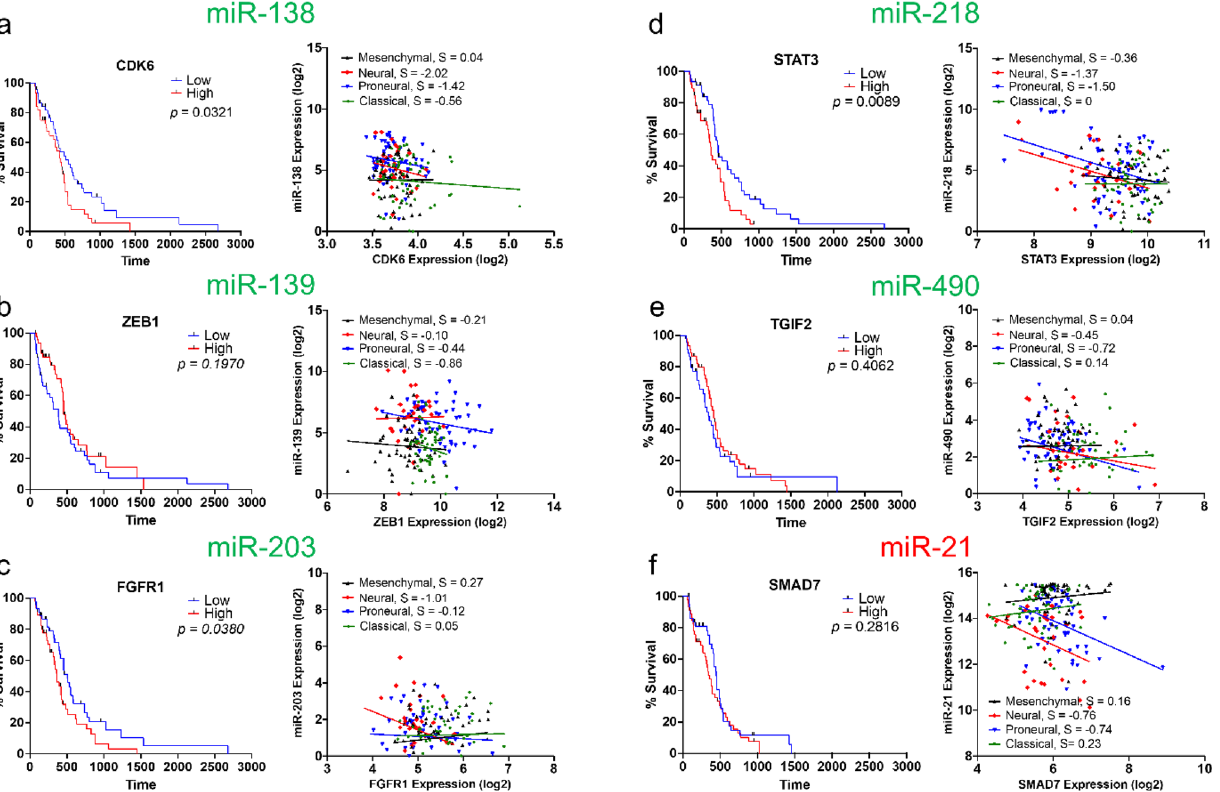
Figure 2. Survival curves of the target genes for each of the six selected miRNAs, and correlation of each target genes with respective miRNA expression. Correlation between the target gene and miRNA were studied in four different GBM subtypes: mesenchymal, neural, proneural, and classical. ( a ) miRNA-138/CDK6-involved in proliferation. ( b ) miRNA-139/ZEB1-involved in migration and invasiveness. ( c ) miRNA-203/FGFR1- involved in mesenchymal transition. ( d ) miRNA-218/STAT3-involved in cytokine signaling. ( e ) miRNA-490/ TGIF2-involved in EMT. ( f ) miRNA-21/SMAD7-involved in invasion and drug resistance. In survival analysis plots, p indicates the P-value. Low and High refer to top and bottom 20% of expressions. In correlation plots, S- indicates the slope of the regression line fitted on the expression data. Complete plots of all target genes that were found for each miRNA are shown in Supplementary Fig. S1